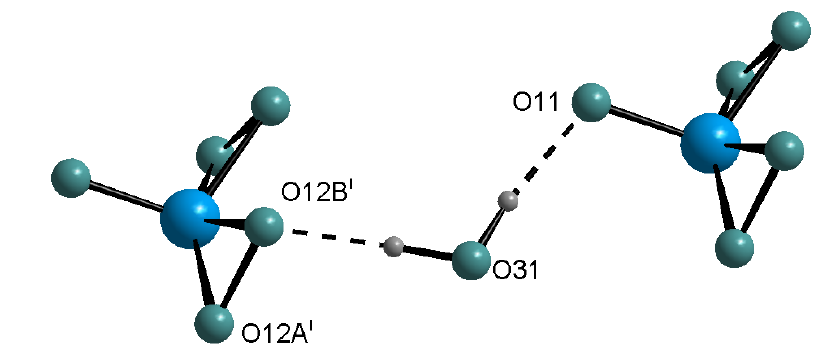
Figure 5. A detail of hydrogen bond. Symmetry code: i)